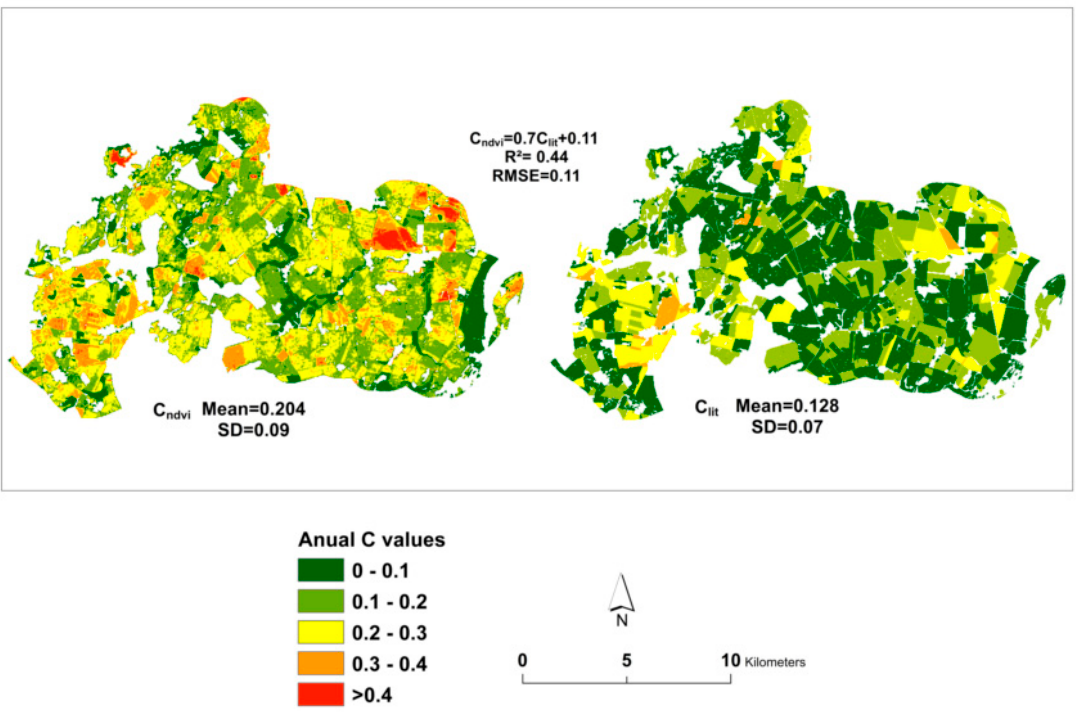
Figure 4. Spatial distribution of three years average annual C values calculated from satellite images (C ndvi ) and literature values (C lit ) over the entire study area.